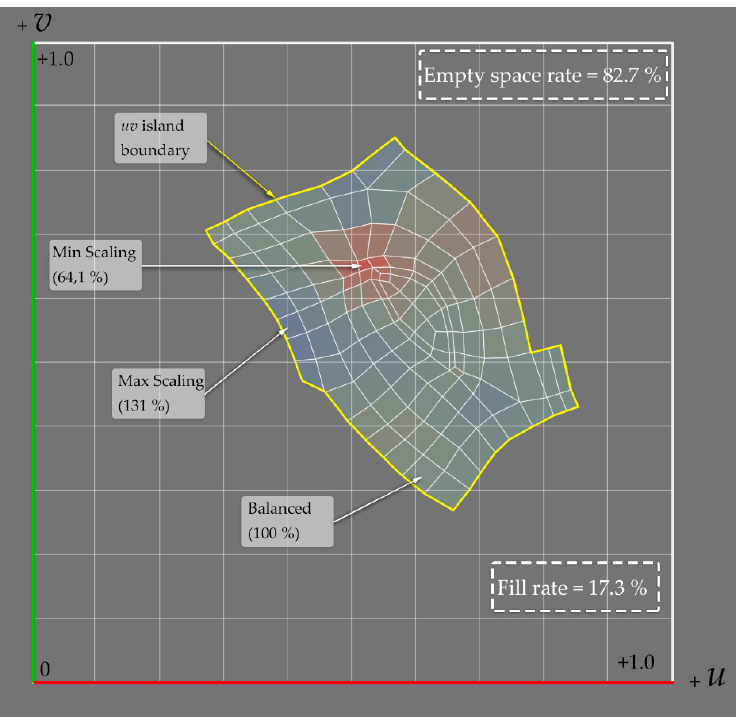
Figure 16. ‘Waviness’ effect on cylindric and ‘hard-box’ models ( a ); additional loops of edges do not solve the problem ( b ); edge hardening on ( u,v ) island boundaries improves the visual quality ( c ); increased amount of polygons can solve the problem in combination with edge hardening ( d ).